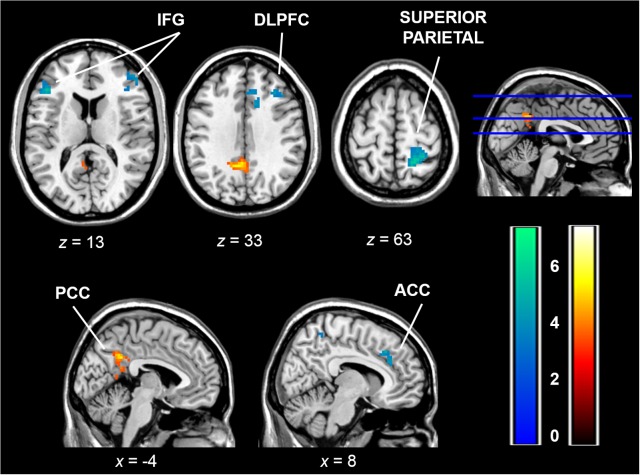
Regression analysis.Whole-brain correlation maps between brain activity in the Switch > Repeat contrast and SR scores (p < .05, cluster corrected with an auxiliary threshold of p < .001). Color bars depict negative (blue-green) and positive (red-yellow) t values. The right side of the image is the right side of the brain. PCC = posterior cingulate cortex; ACC = anterior cingulate cortex; IFG: inferior frontal gyrus; DLPFC: dorsolateral prefrontal cortex.